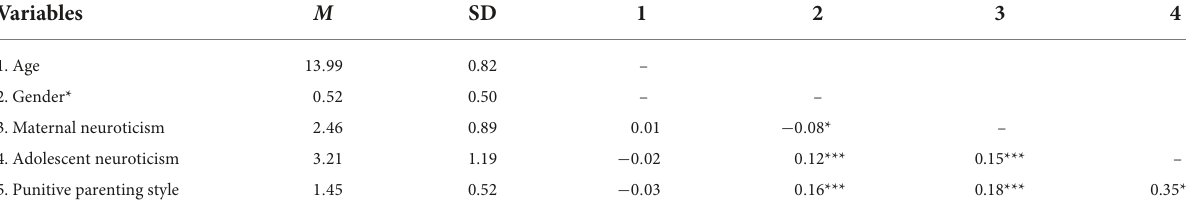
TABLE 1 Mean, standard deviation, and correlation coefficient of each variable.